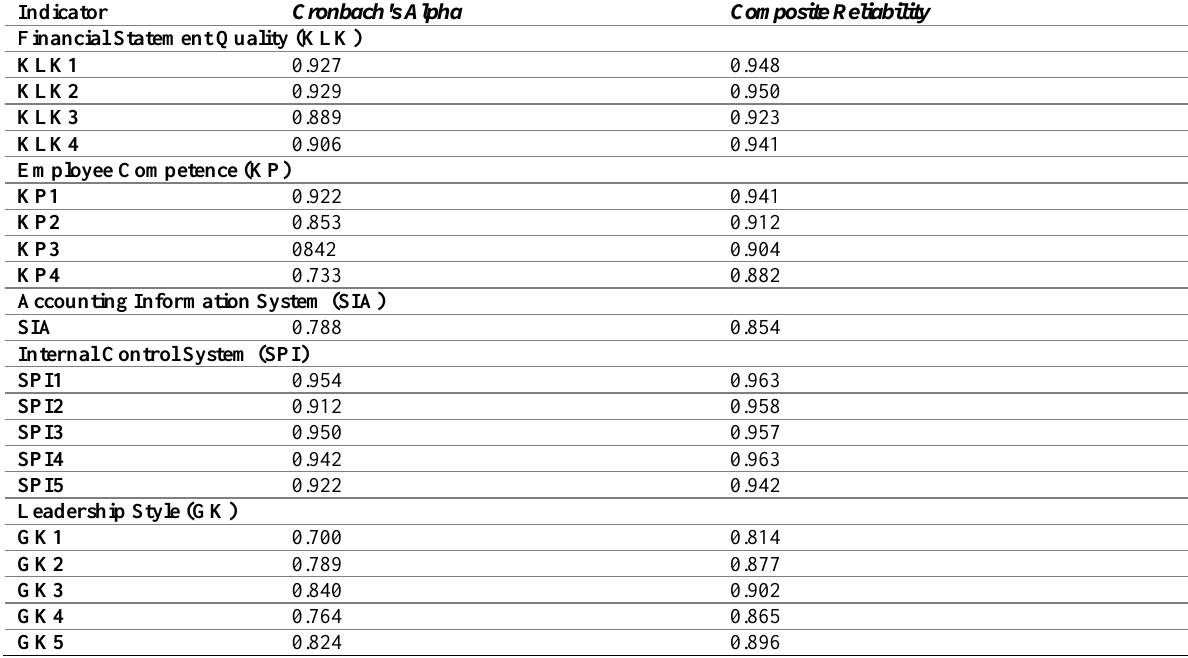
Table 3: Reliability Test Results